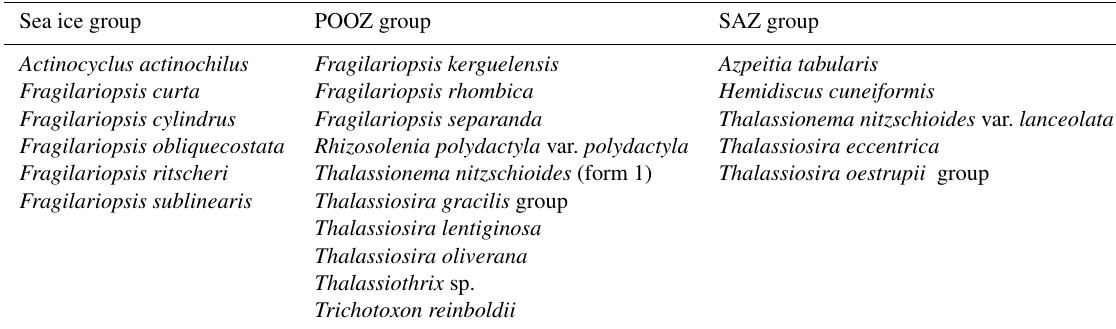
Table 1. Species comprising each of the diatom taxonomic groups (updated from Crosta et al., 2004).